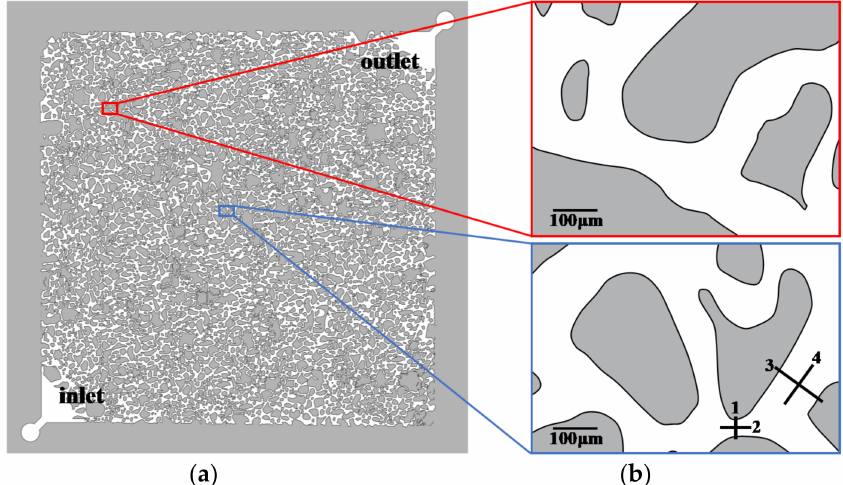
Figure 1. The sketch of the micro model ( a ) and the selected observation sites ( b ) in the main stream (lower image) and margin region (upper image).